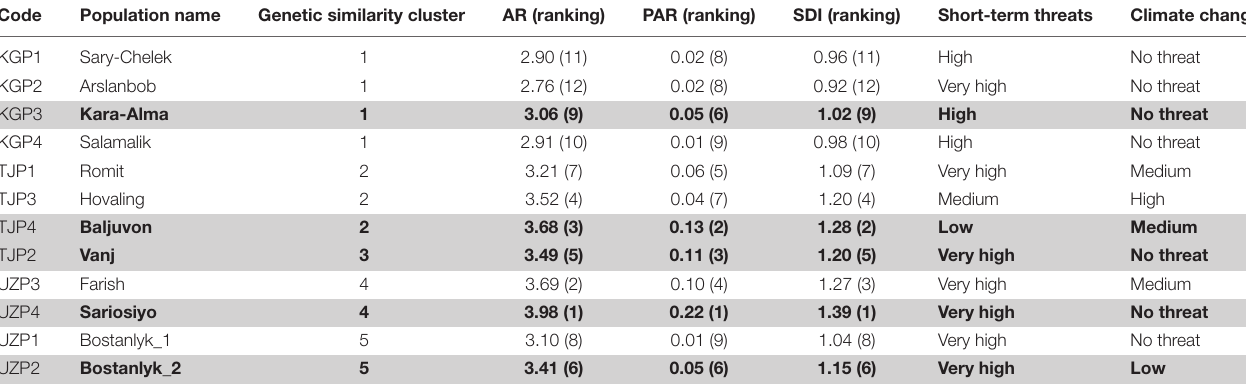
TABLE 6 | Genetic diversity ranking and threat magnitude classes assigned to the 12 wild common walnut